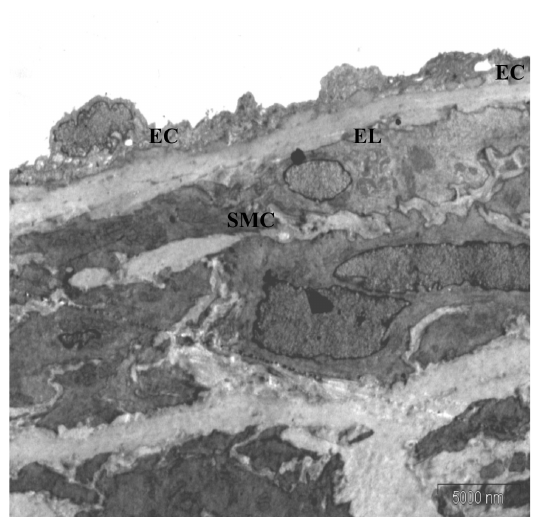
Figure 5 - (Original magnification x 4400) Electron microscopic findings on the aorta of TRF group following eight weeks of study. The elastic lamina (EL) appeared more regular, and smooth muscle cells (SMC) did not actively proliferate. The endothelial cells (EC) still display squamous